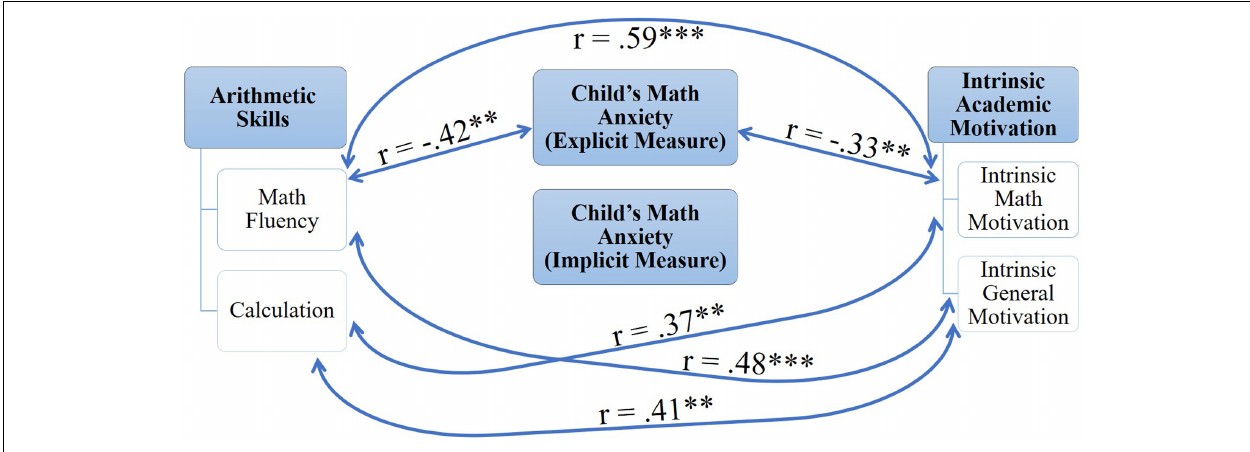
FIGURE 3 | A schematic summary of the correlations between children’s variables. ∗∗ p < 0.05, ∗∗∗ p < 0.01